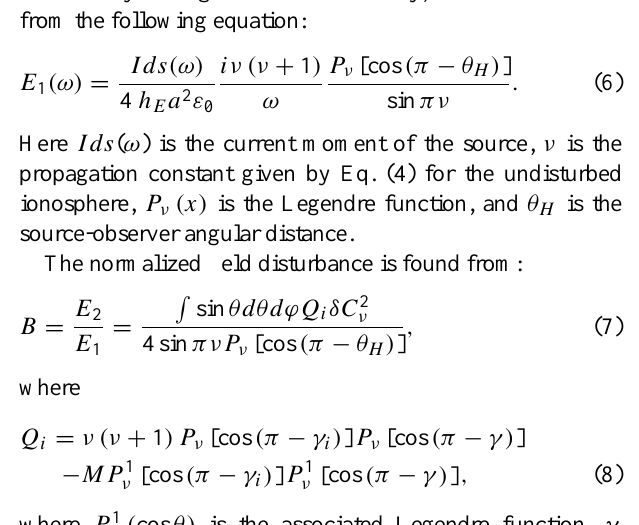
Fig. 2. Geometry of the wave scattering from a localized disturbance.